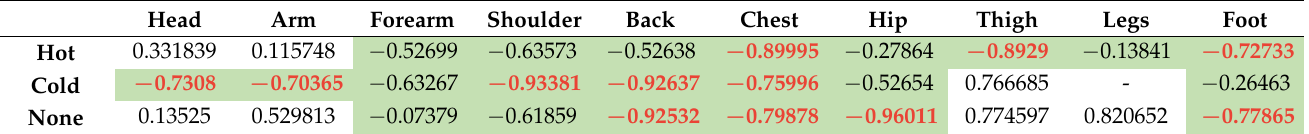
Table 16. Correlation between the difference of the thermal sensation level and the neutral sensation and the thermal comfort sensation for the hot-sensitive, cold-sensitive, and neutral